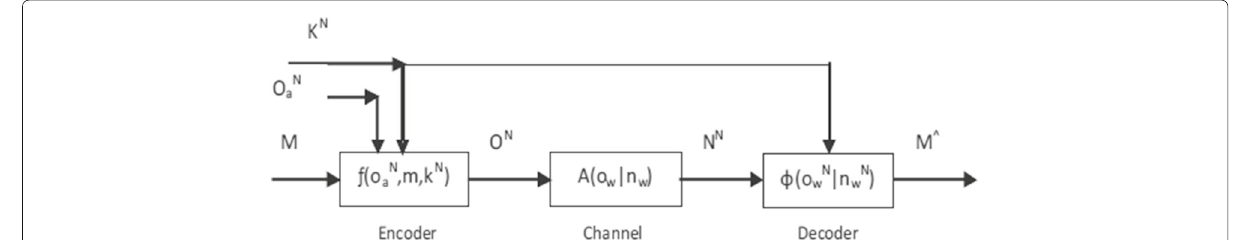
Fig. 8 Modeling of proposed watermarking technique as discrete memoryless